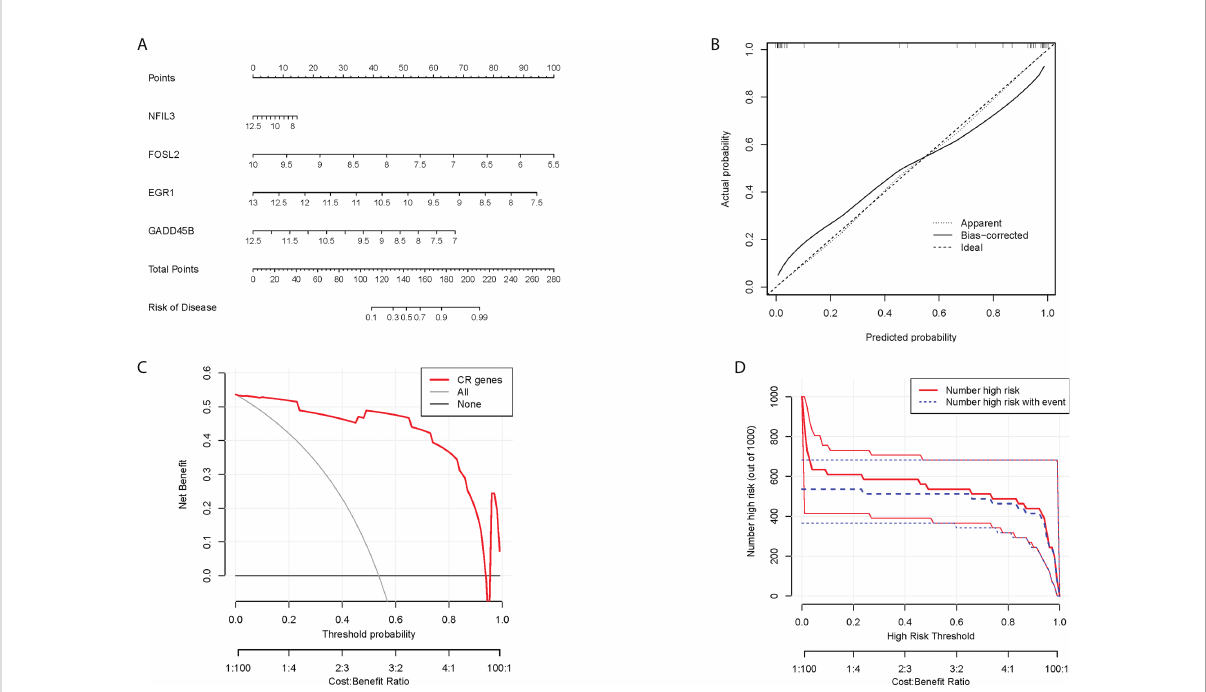
FIGURE 8 Nomogram model. (A) Nomogram of hub CRGs. (B) Calibration curve of the model. (C) Clinical decision curve. (D) Clinical impact curve (The red curve indicated the number of people classi fi ed as positive (high risk) by the model at each threshold probability; the blue curve indicated the number of true positive people at each threshold